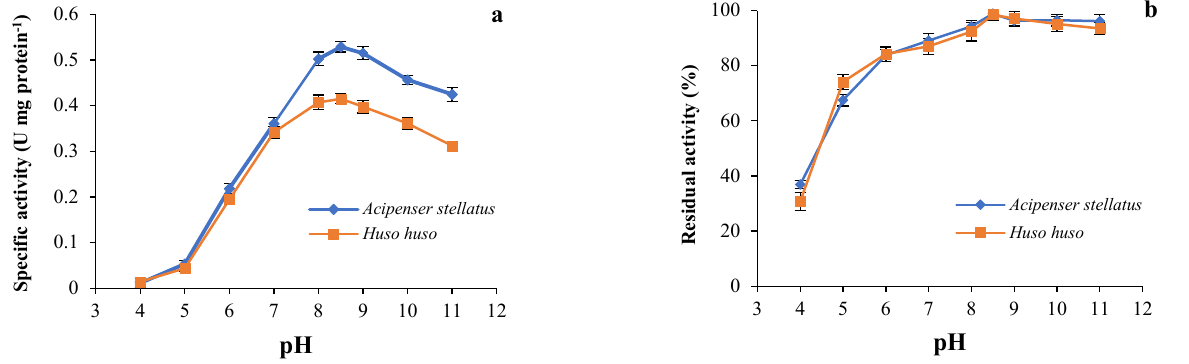
Figure 3. ( a ) Optimum pH: the enzymatic activity of both trypsins was determined at different pHs at 55 ◦ C using BAPNA as a substrate; ( b ) pH stability: residual activity of both enzymes was measured at 55 ◦ C and pH 8.5 after incubating at different pHs for 30 min using BAPNA as substrate. The effect of pH on the trypsin stability in both ICEs is displayed in Figure 3b. The stability of both enzymes was considerably retained between pH 6.0 to 11.0. Trypsin activity was lost about 63.15% and 69.26% at pH 4.0 in sevruga and beluga, respectively, while the loss of the enzyme activity at pH 5.0 was recorded by 34.13% and 35.84% for sevruga and beluga, respectively. However, trypsin in ICE of sevruga and beluga lost only 1.19% and 1.51% of its activity at pH 8.5, respectively. Similar behavior was reported for trypsins from common kilka [40], common dolphinfish [55], and zebra blenny [56] which retained 80–100% of the activity at pH ranges of neutral and alkaline. The high catalytic activity of the trypsin is observed in alkaline pHs, and its stability at a particular pH may be linked to the net charge of the enzyme at that pH [75].